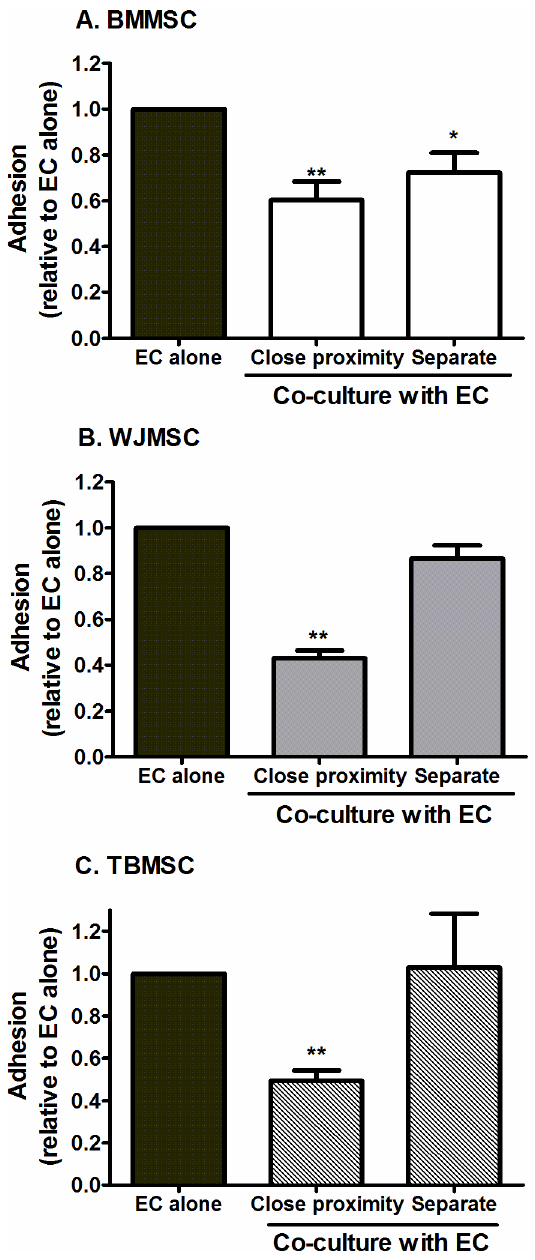
Fig 5. Effects of varying proximity between MSC and EC on neutrophil recruitment. Co-cultures were formed by seeding BMMSC, WJMSC, or TBMSC on the opposite side of a Transwell filter to EC (Close proximity) or by seeding MSC on the plate below EC cultured on a filter (Separate). Neutrophil adhesion was expressed as a proportion of that observed on the paired EC mono-culture control where a different EC and neutrophil donor was used in each experiment. ANOVA showed a significant effect of culture conditions on neutrophil adhesion for each type of MSC, p < 0.01. Data are mean ± SEM, n = 11 for EC alone and close proximity co-cultures or n = 3 for separate co-cultures. (A) 5 or 2 different BMMSC donors were used for close proximity or separate cultures respectively, (B) 3 different WJMSC and (C) 3 different TBMSC donors were used for both culture models. * = p < 0.05 and ** = p < 0.01 compared to EC mono-cultures by Dunnett post-